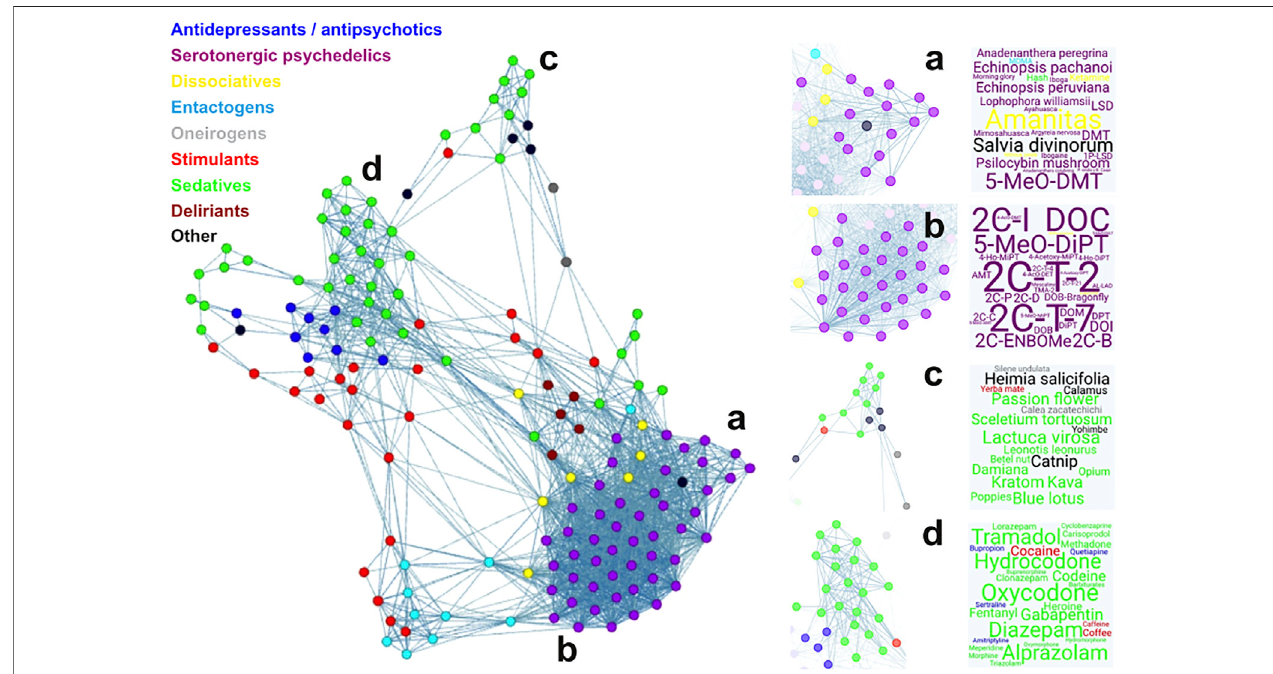
FIGURE 5 | Semantic similarity network for reports of drug-induced experience (Sanz et al., 2018). Each node represents the combined Erowid ’ s reports for a certain drug, colored according to categories based on their known effectsand mechanism ofaction (see labels in the upper left). A connection between apair ofnodes indicates that the corresponding pair of reports present a suf fi ciently high degree of semantic similarity. The network was drawn using the ForceAtlas layout included in Gephi (https://gephi.org/), which tends to separate and identify groups of highly interconnected nodes that have sparser connections with the rest of the network (known as modules ). Subpanels highlight different network modules, and the associated word clouds contain the name of drugs belonging to each module, with size weighted by their average strength of within module connections. These modules correspond to mostly natural and synthetic psychedelics (panels (A,B) , respectively), and to mostly natural and synthetic sedatives (panels (C,D) ,